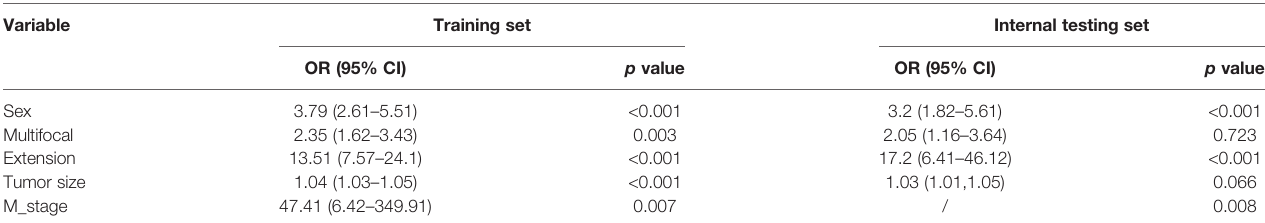
TABLE 2 | Multivariate analysis results for LLNM in MTC patients. Variable